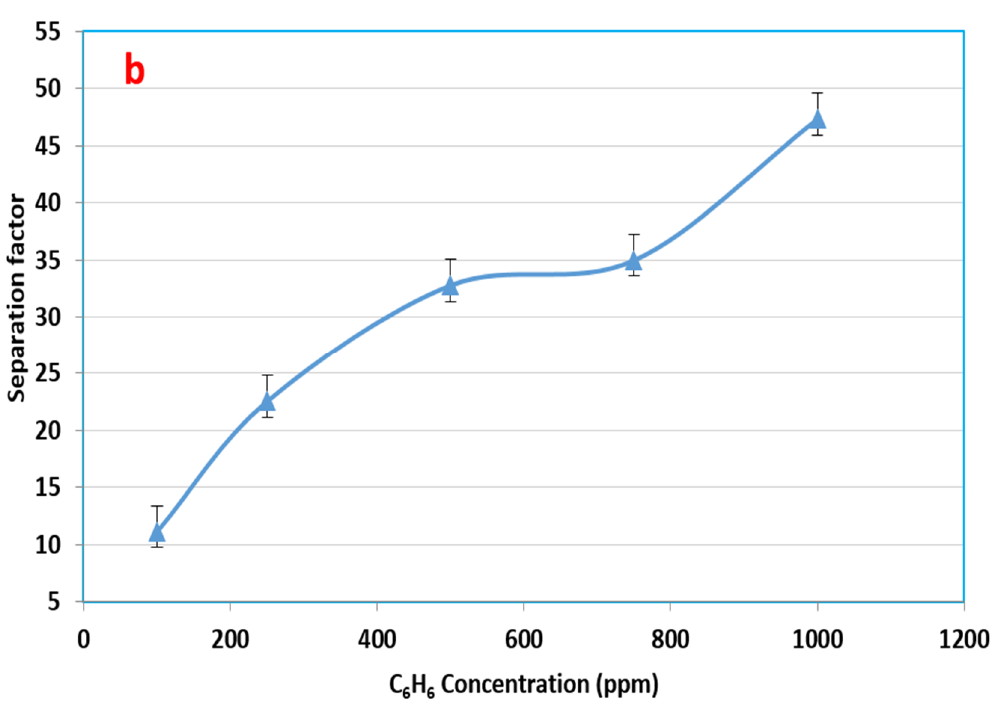
Figure 5. Effect of the initial benzene feed concentration on ( a ) the flux of benzene and water and ( b ) the separation factor at a feed temperature of 30 °C and a 3 L/min feed flow rate.